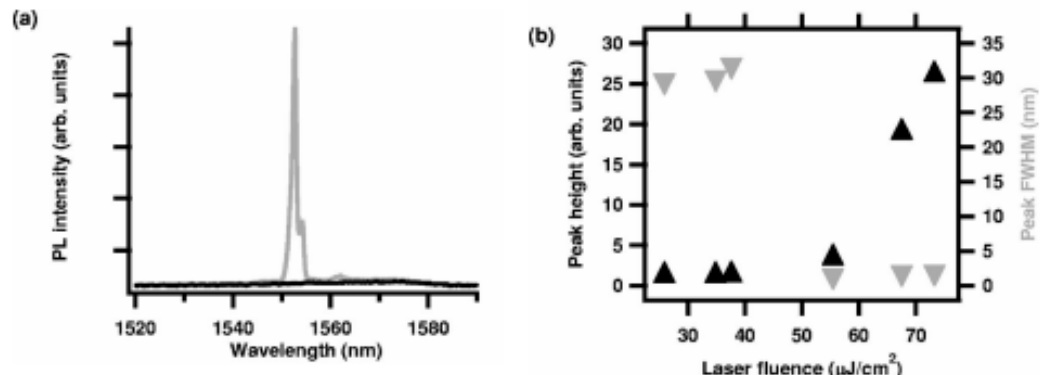
Figure 12. GaSb semiconductor subwavelength wires (SWW) NIR lasing, ( a ) PL spectra below (black) and well above threshold (gray), ( b ) Peak PL height at the lasing line wavelength of 1553 nm (black, up triangles) and PL width (gray, down triangles) vs laser fluence. Reproduced with permission from [71], copyright AIP Publishing LLC (2006).